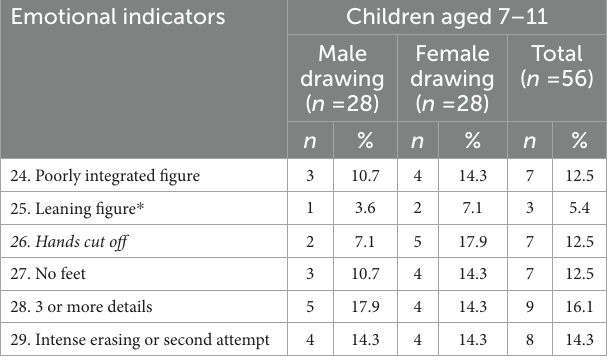
TABLE 5 Frequencies of emotional indicators from age 7 in Two Human Figure test (T2F).